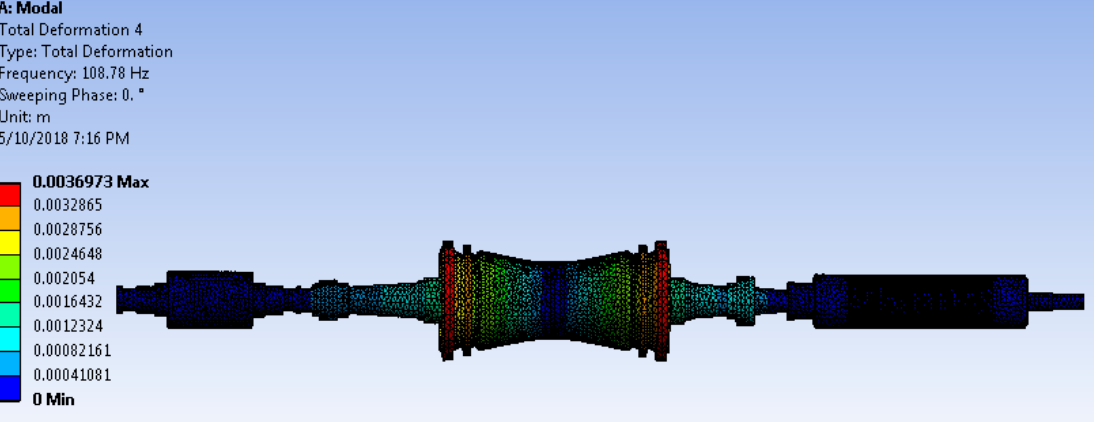
Figure 15. Concept 1 Mode 4 torsional natural frequency and deformation.